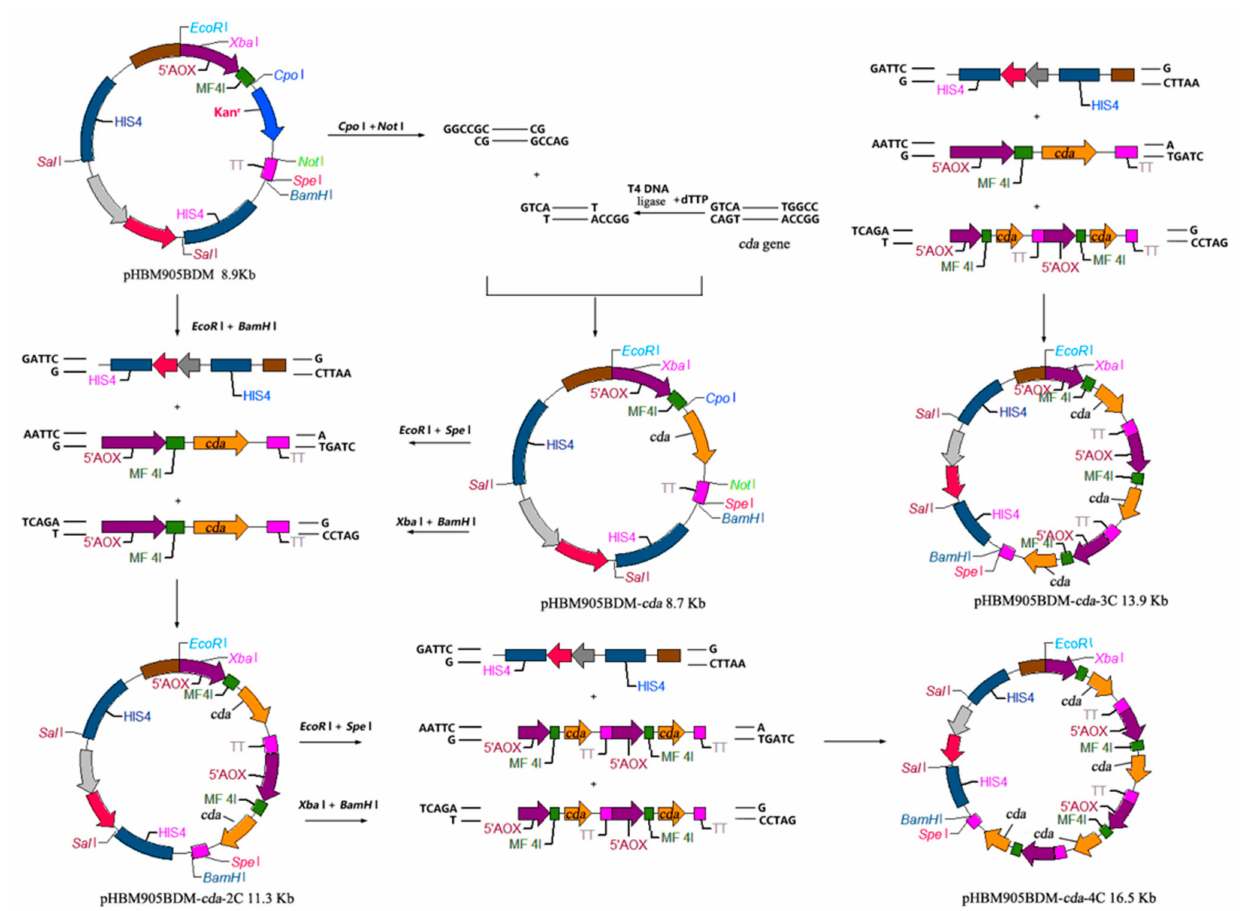
Figure 1. The construction of pHBM905BDM expression